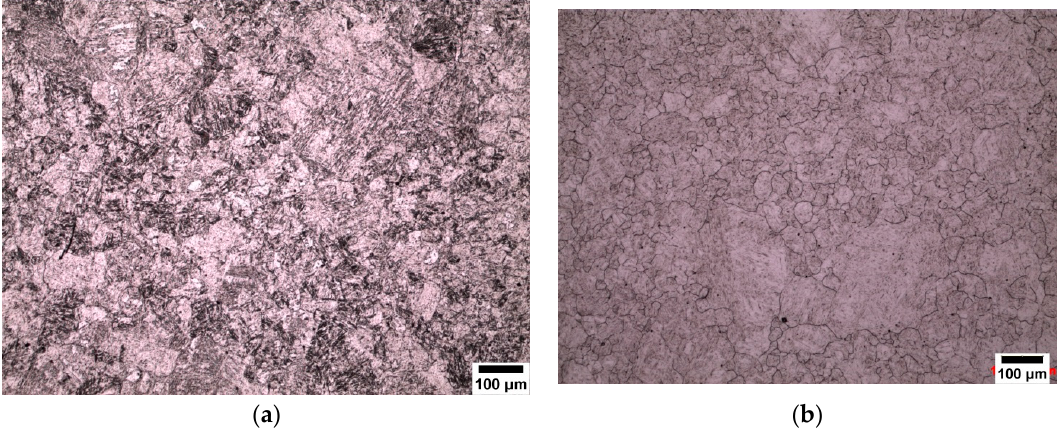
Figure 13. The sample shown in ( a ) has been continuously swabbed during the etching process, and the sample shown in ( b ) has been swabbed once after the formation of the etchant layer. Both samples were 0.8 wt.% carbon with 0.005 wt.% niobium and with sodium dodecyl sulfate used in the